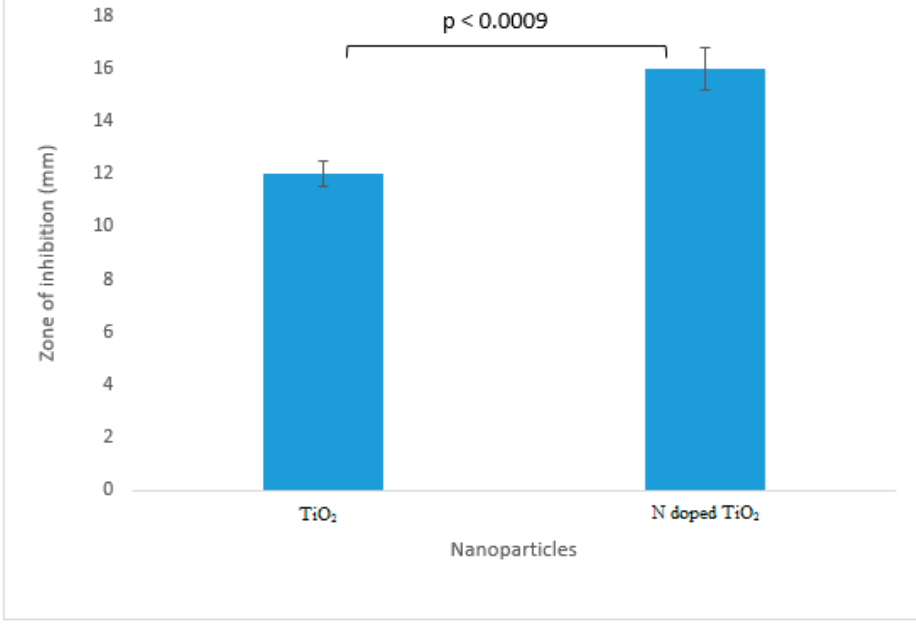
Figure 12. Protein kinase inhibition exhibited by TiO 2 nanoparticles and N-doped TiO 2 nanoparticles. Error bars are shown as standard deviation on each bar. Bars are significantly different at confidence interval level of 95%.